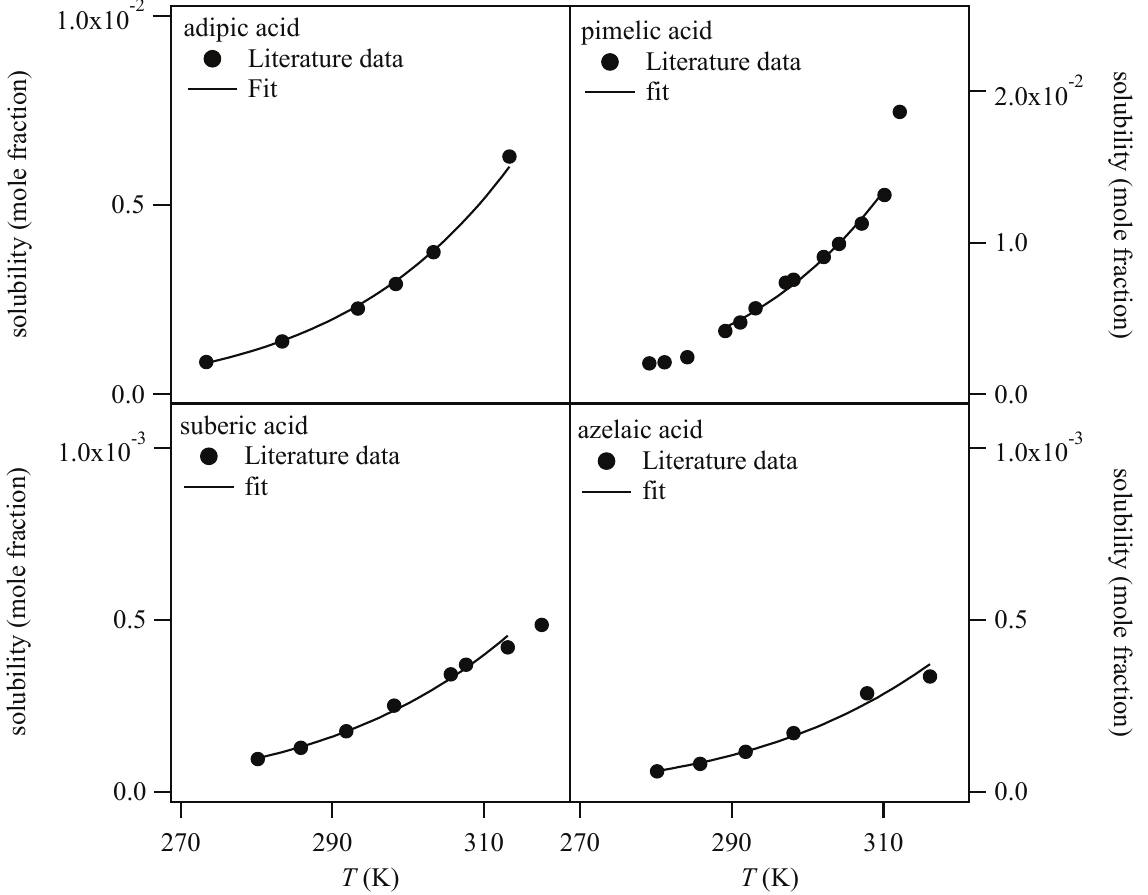
Fig. A1. Summary of solubility of adipic, pimelic, suberic, and azelaic acids as a function of temperature (Apelblat and Manzurola, 1989; 1990; Gaivoronskii and Granzhan, 2005). The fitting results are also shown (Eq. A1). Table A1. Summary of parameters for the Apelblat-Manzurola equation (Eq. A1). Compound